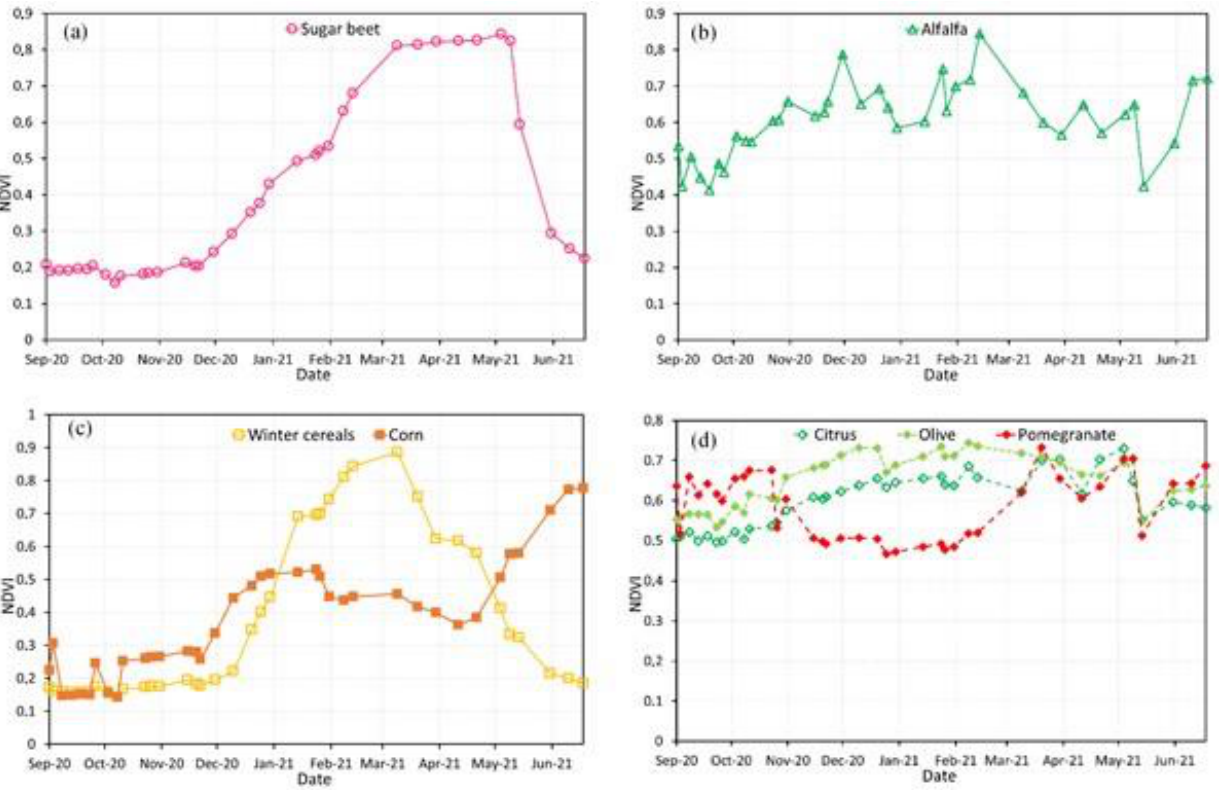
Figure 7. NDVI spectral curves for major crop types planted in t2020/2021: ( a ) Sugar beet; ( b ) Alfalfa; ( c ) Winter cereals (wheat and barley) and corn; ( d ) Tree crops (pomegranates, citrus, and olive).